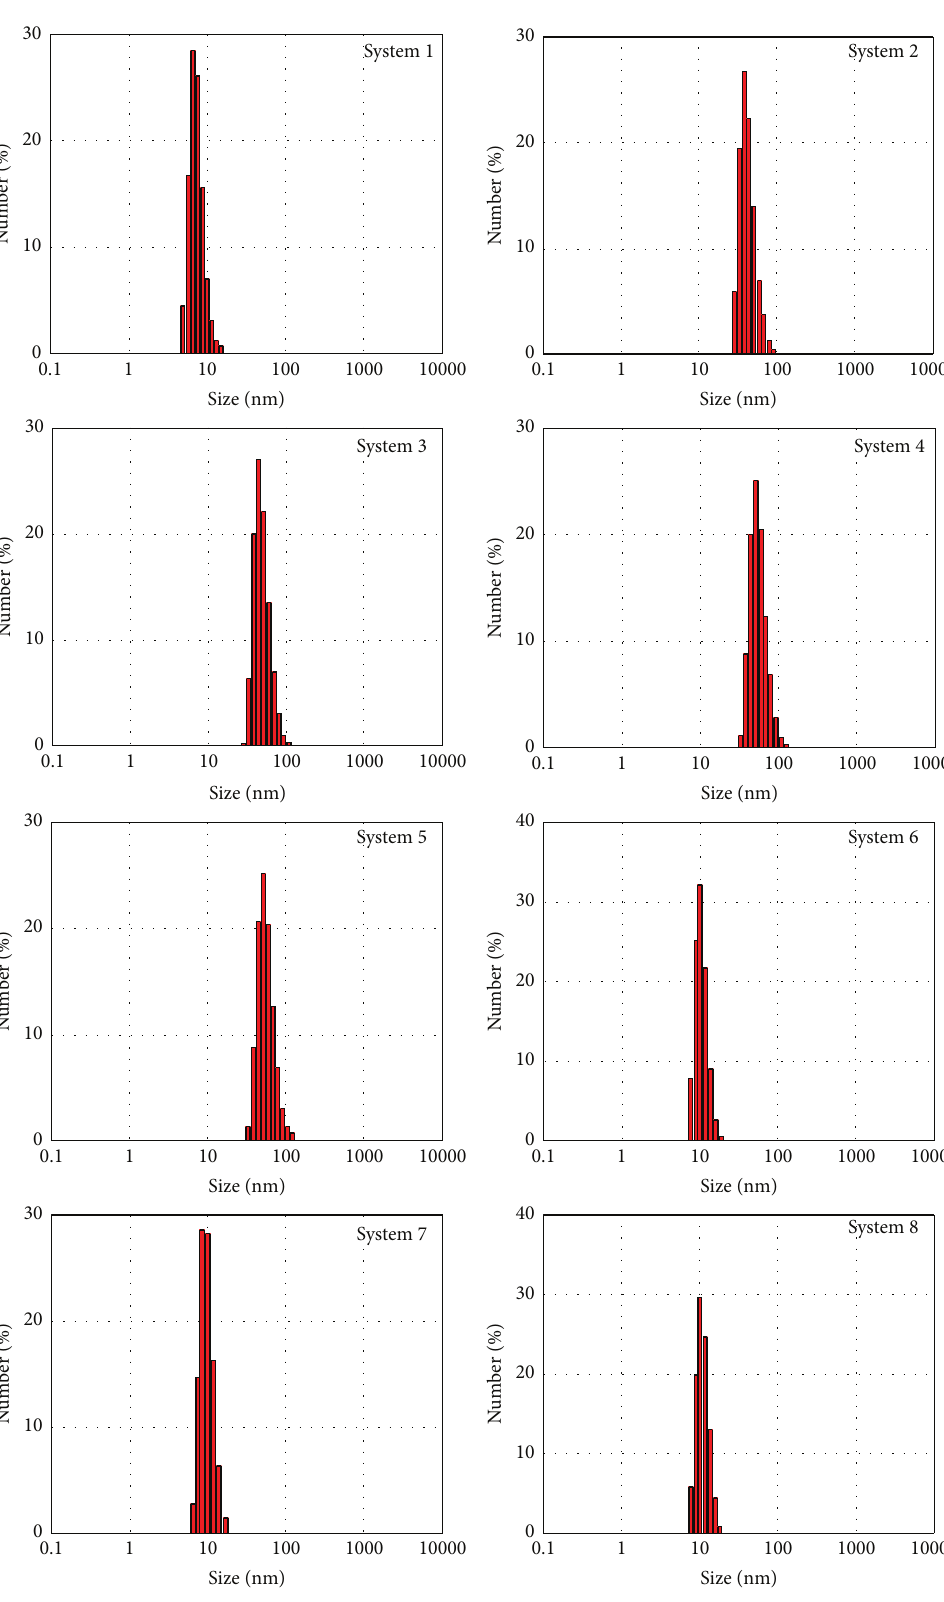
Figure 3: The size distribution of silver